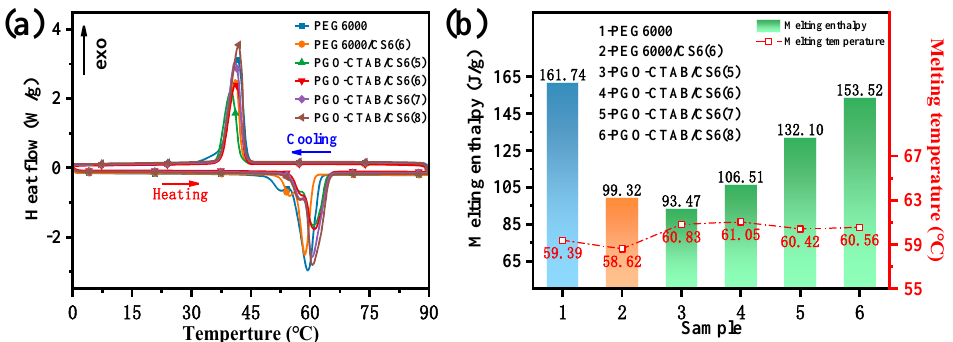
Figure 7. ( a ) DSC curves ( b ) and latent heat values of PEG6000, PEG6000/CS6(6) and PGO- CTAB/CS6(5\6\7\8) PCMs. Table 2. Latent heat performance parameters of various PCMs.